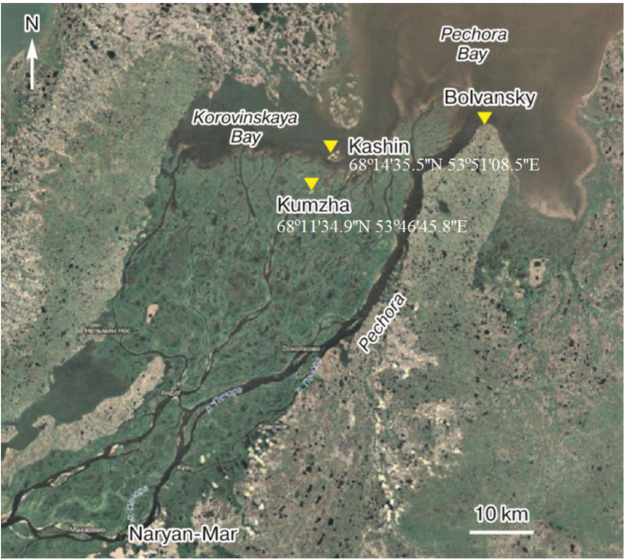
Figure 1. Locations of the Kashin (CALM 24A-1) and Kumzha (CALM 24A-2) study